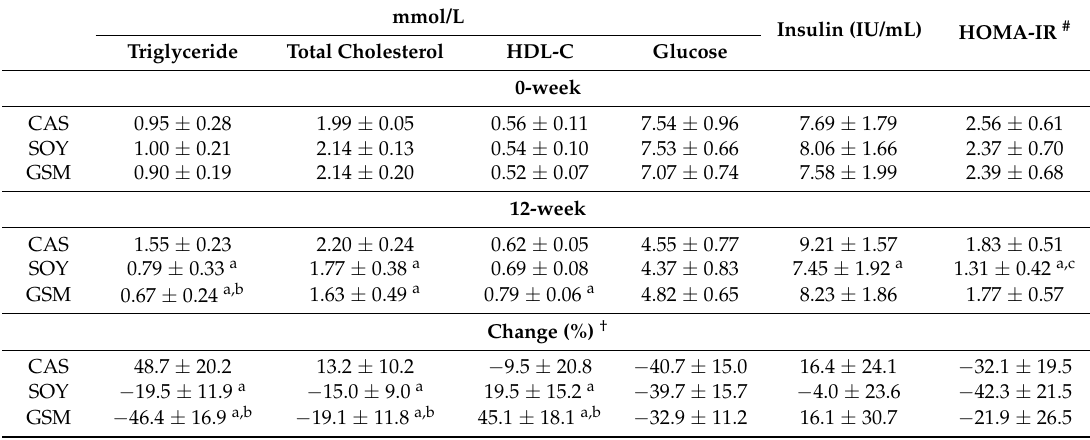
Figure 2. Change of body weights of rats from three groups over the 12-week feeding period. Body weights of rats at the end of the study were statistically analyzed by one-way ANOVA followed by LSD-test; * p < 0.05 versus CAS and GSM group. Table 3. Fasting blood lipid, metabolic, and insulin responses in rats fed with different dietary proteins †, *.